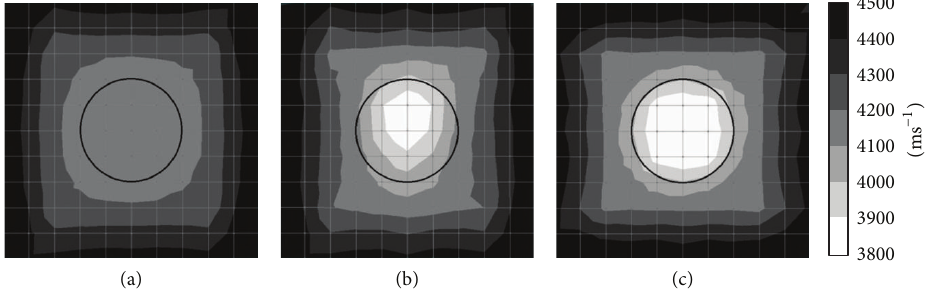
Figure 5: Tomograms of model with a total number of 20 sensors attached to four sides: (a) 0% void; (b) 50% void; and (c) 100% void.